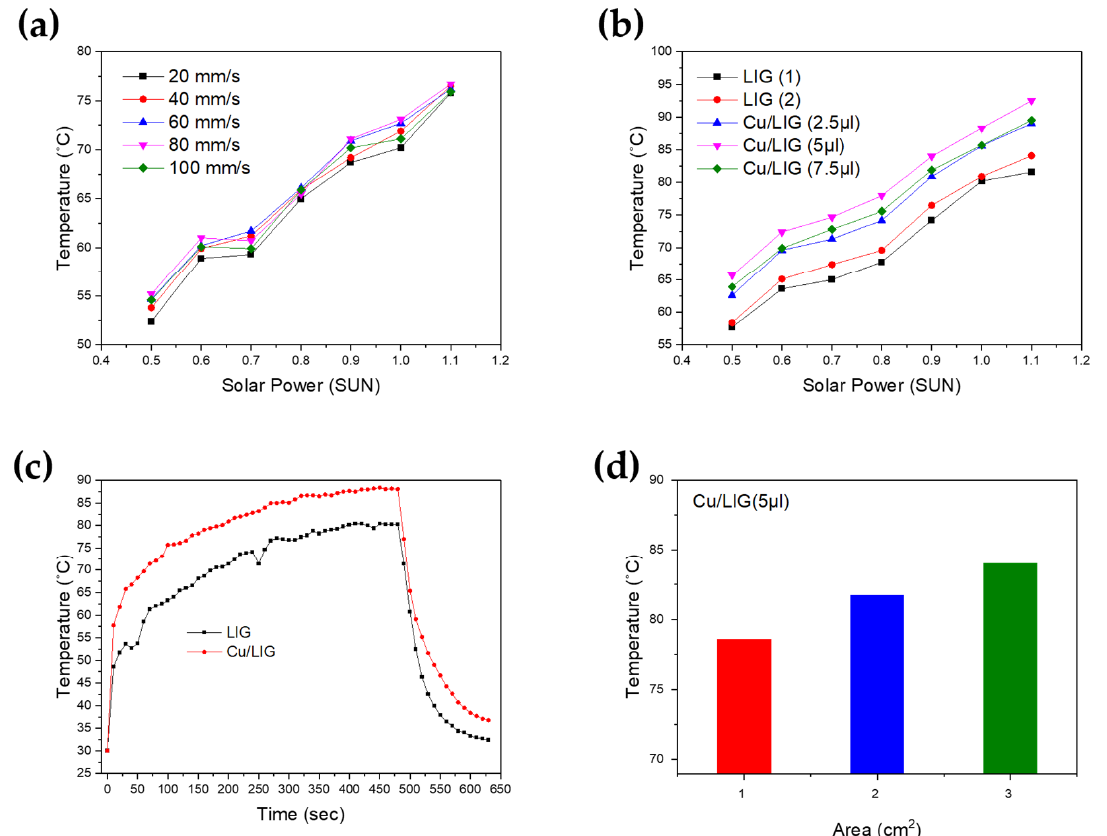
Figure 4. ( a , b ) Temperature as a function of solar power for LIG patterns, ( c ) photothermal rising and cooling time of LIG and Cu/LIG, ( d ) sample area-dependence of the temperature. and cooling time of LIG and Cu/LIG, ( d ) sample area-dependence of the